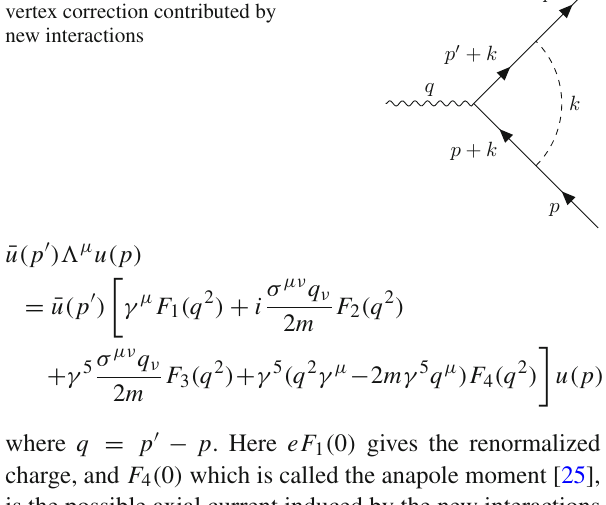
Fig. 1 The electromagnetic vertex correction contributed by new